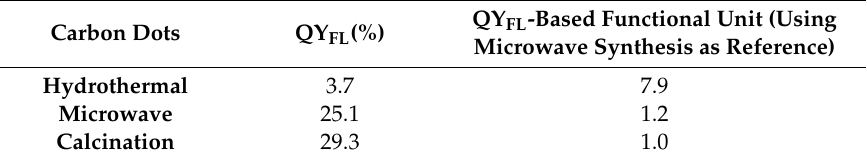
Table 3. Fluorescence quantum yields (QY FL ) and QY FL -based functional units.